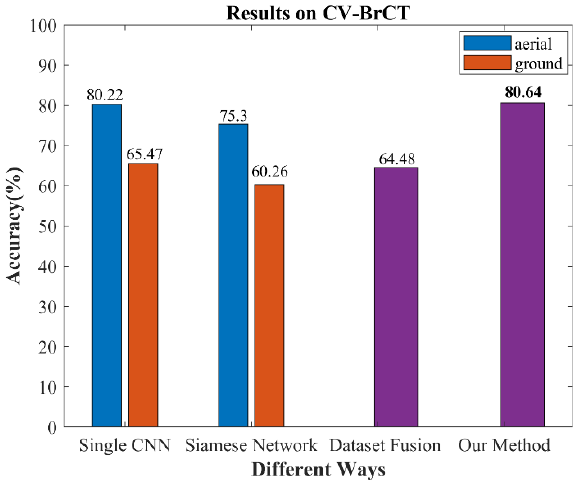
Figure 8. Results of different methods on